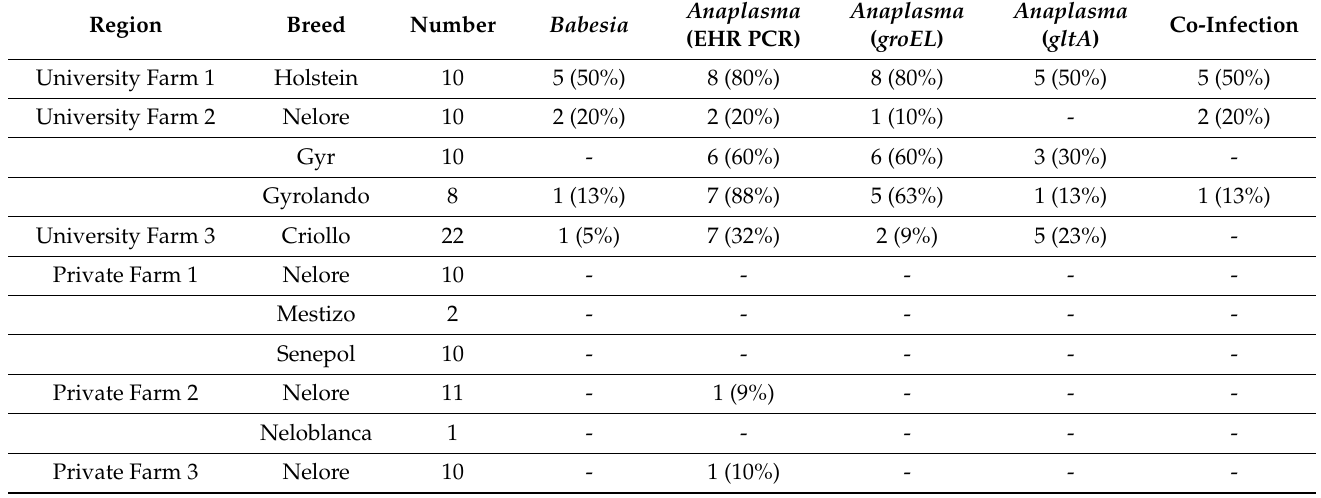
Table 2. Infection rate of Babesia and Anaplasma